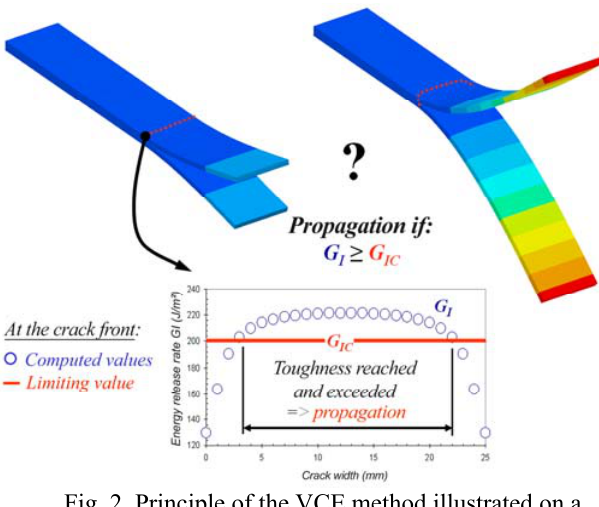
Fig. 2. Principle of the VCE method illustrated on a Double Cantilever Beam (DCB)